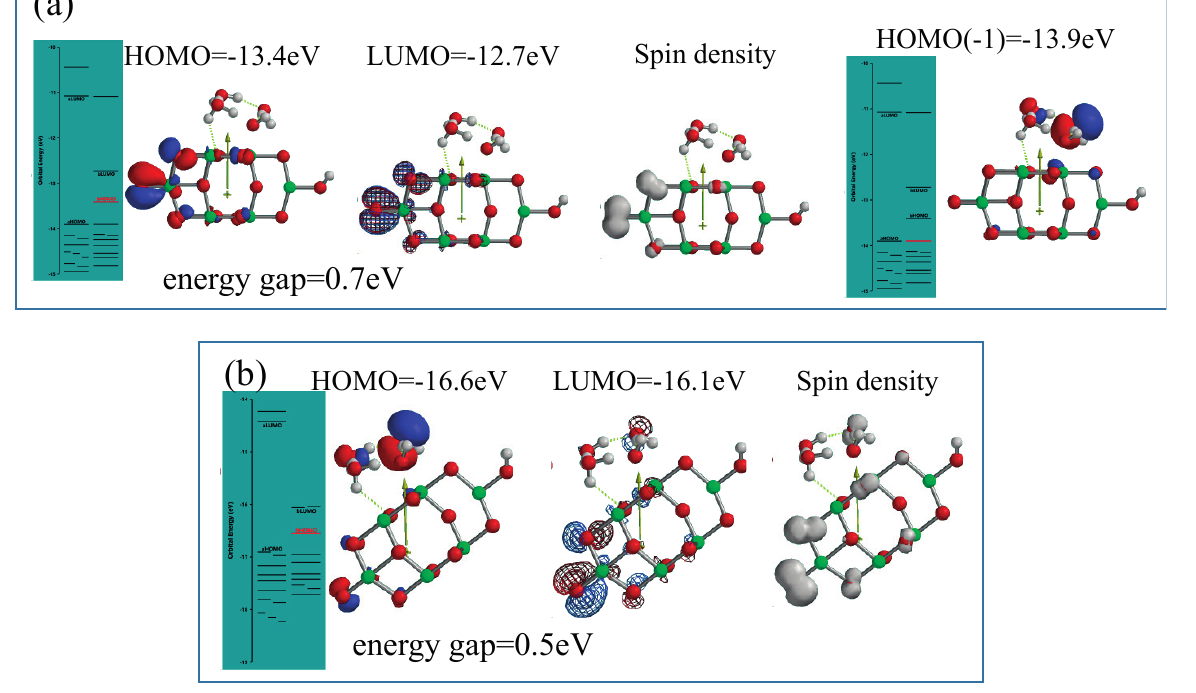
Figure 9. DFT-simulation of oxidation states of H 3 O + (H 2 O) 2 &OH(TiO 2 ) 9 H, ( a )